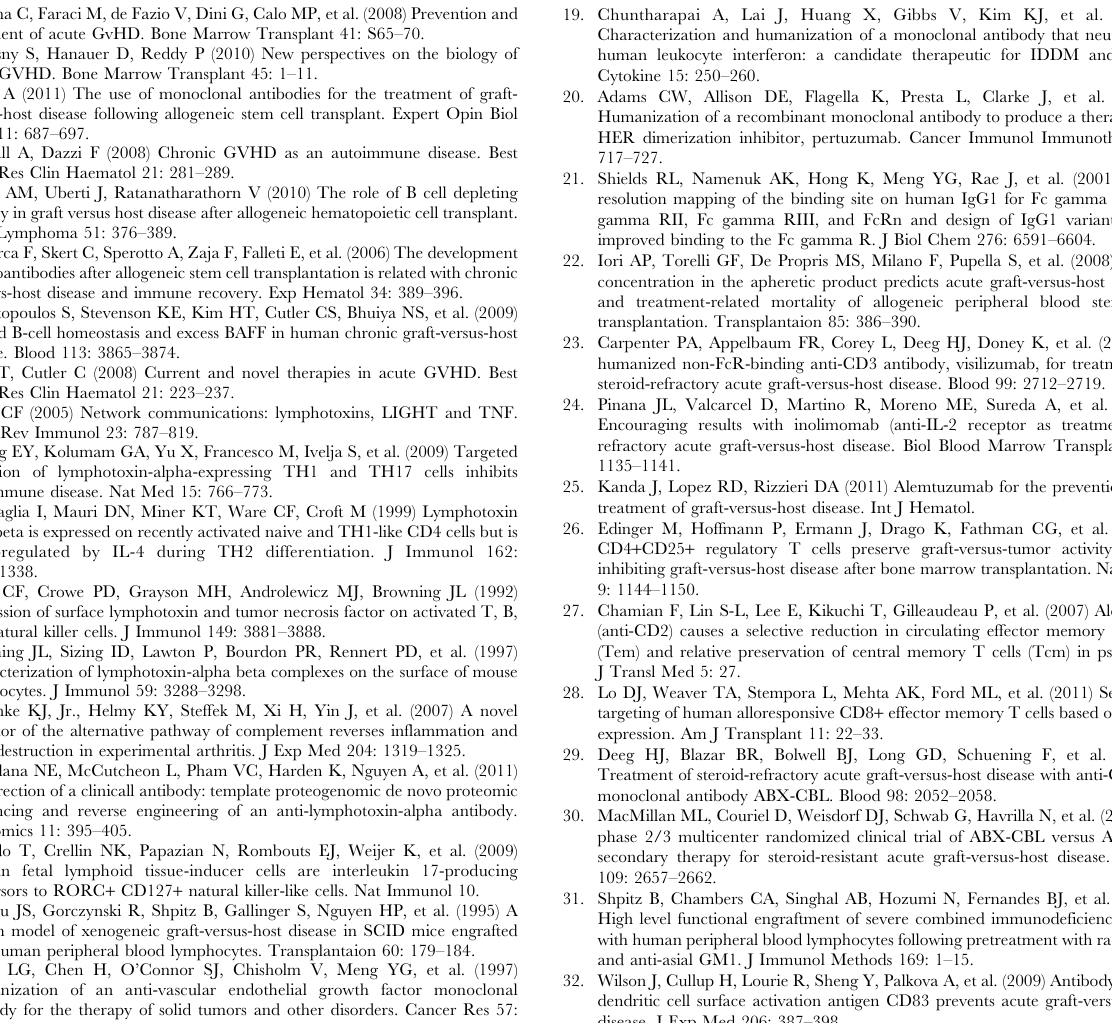
Figure S2 Anti-LT- a mAb reduces frequency of LT-expressing proliferating human CD4 + T cells in Hu-SCID GVHD model. Spleens were harvested from SCID mice four days following intrasplenic injection of human PBMCs, after three days treatment with anti-LT- a MLTA3698A, anti-LT- a -FcMT or isotype control mAb. Cells were gated for CD4 + T cells, then LT expression was analyzed on CFSE-labeled transferred cells. Data are representa- tive of three